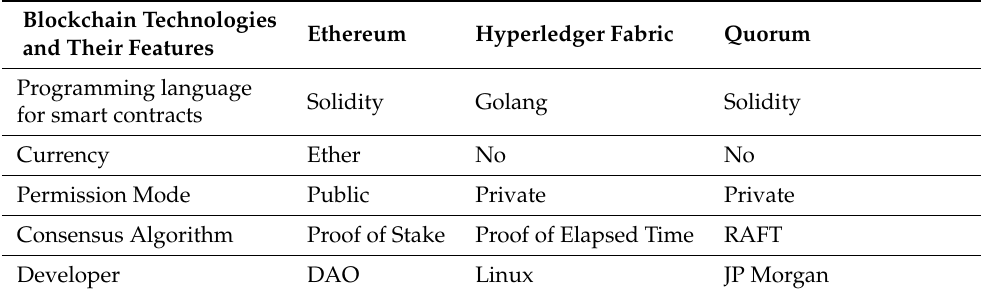
Table 1. Blockchain technologies for smart